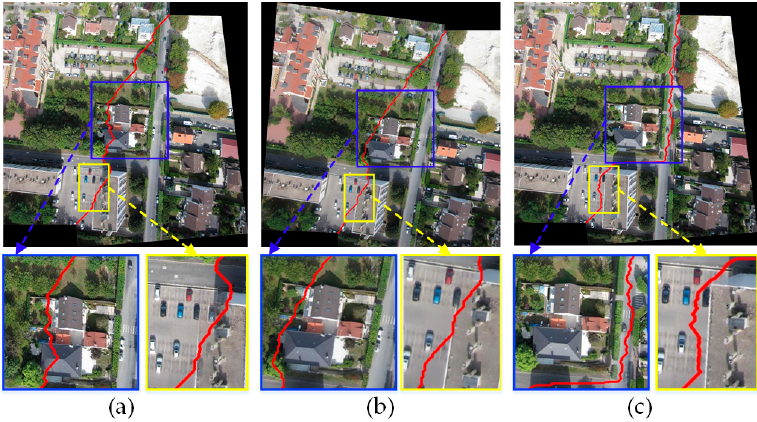
Figure 10. The seam lines of different searching algorithms for Figure 7a: ( a ) Duplaquet algorithm; ( b ) OpenCV algorithm; ( c ) Our algorithm.